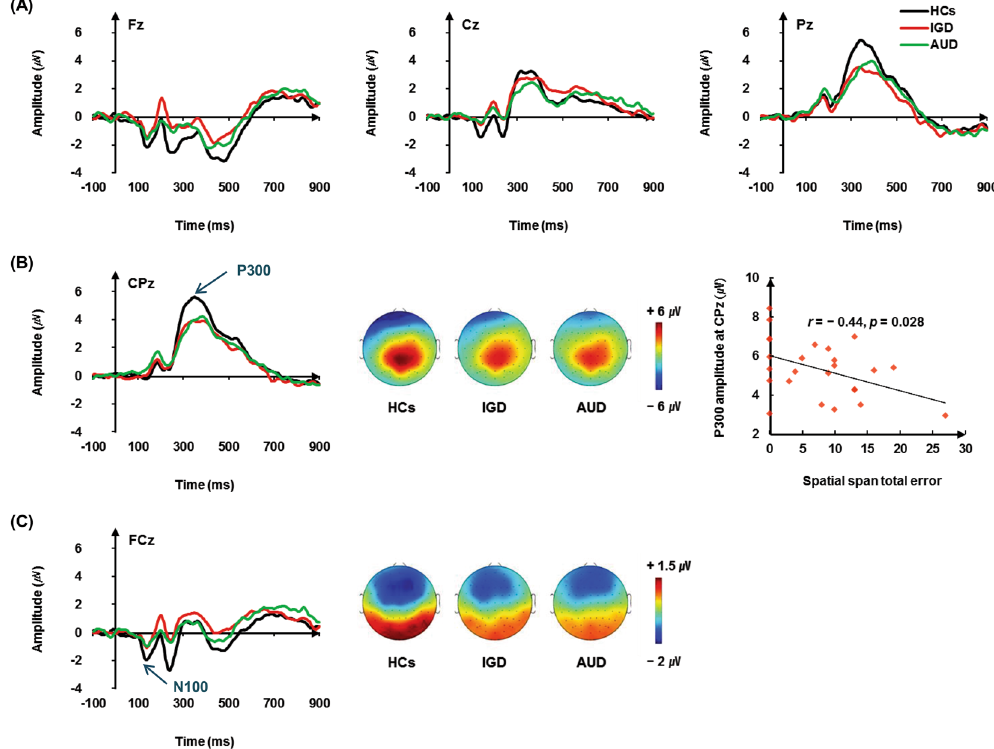
Figure 1. Grand-average event-related potential (ERP) waveforms and topographic maps. ( A ) Grand-average ERP waveforms over three electrode regions (Fz, Cz, and Pz) elicited by deviant tones in the auditory oddball task in patients with Internet gaming disorder (IGD) or alcohol use disorder (AUD) and healthy controls (HCs). ( B ) Grand-average ERP waveforms over CPz (left), topographic maps displaying scalp distribution of P300 amplitude in each group (middle), and correlations between P300 amplitude at the CPz and the total number of errors on the spatial span test in the IGD group (right). ( C ) Grand-average ERP waveforms over FCz (left) and topographic maps displaying scalp distribution of N100 amplitude in each group